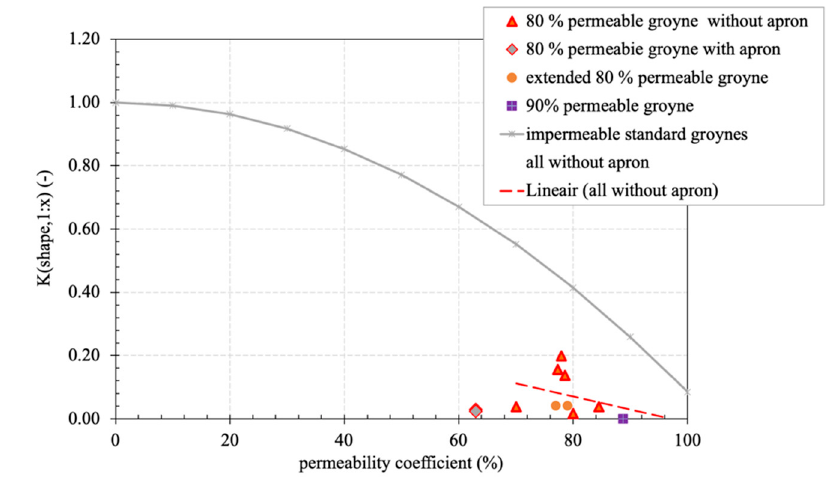
Figure 19. Scour depth as an approximate function of groyne head permeability of a pile row (prepared by